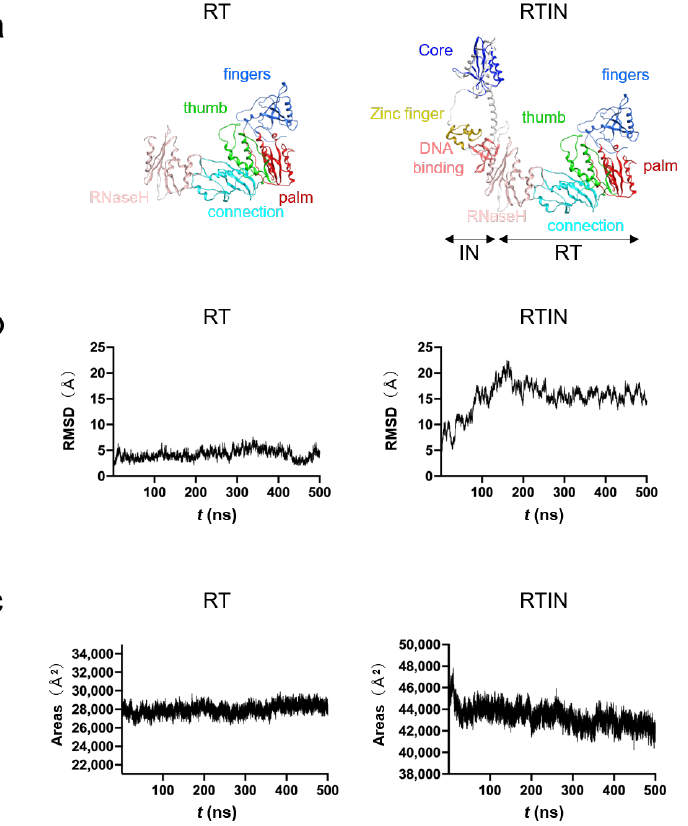
Figure 6. MD simulations of RT and RTIN proteins of the HIV-1 NL4-3 clone. The amino acid sequence of the RTIN portion of the Pol region of the HIV-1 NL4-3 molecular clone [24] was used to construct an RTIN model by the AlphaFold2 program [23]. The obtained RTIN model gave a per-residue confidence score (pLDDT) of 83.3, in the “Confident” range [23]. An RT model was constructed with the RT domain of the RTIN model by deleting the IN domain using MOE (Chemical Computing Group, Montreal, Quebec, Canada). The RT and RTIN models were subjected to MD simulations using modules in Amber 16 [32] as described previously [28,29,31]. ( a ) Initial models of RT and RTIN fusion protein before MD simulations. ( b ) Structural dynamics of RT and RTIN fusion protein during MD simulations. RMSDs between the structure of the initial model and those at given time points of MD simulation were used to monitor the overall structural changes during simulations. ( c ) Analysis of areas of exposed surfaces of RT and RTIN in solution during MD